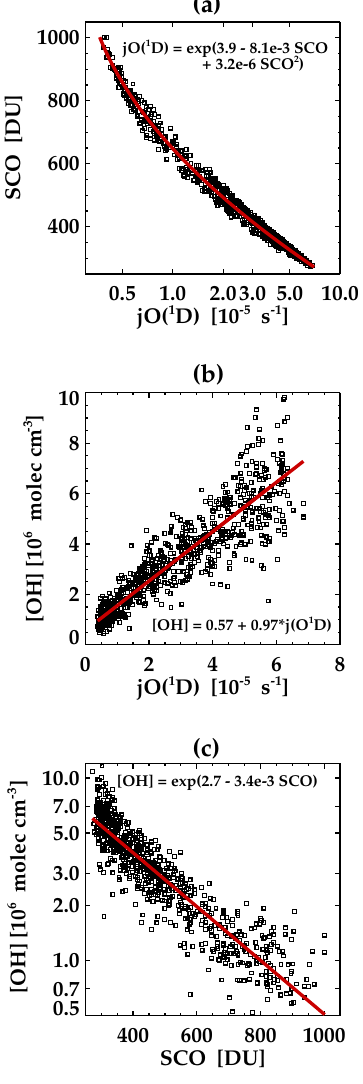
Figure 4. (a) Scatter plot of j with the slant column of O 3 O 1 D (SCO) at 6km of altitude. (b) Same, but for j and OH. (c) Same, O 1 D but for the SCO and OH. The results shown in this figure are those obtained from the combined simulation (kinetics and photolysis effects). Red lines denote least-squares fits between the variable pairs. The best fits are stated in the panels, with [OH] in units of 10 6 molcm − 3 , j in units of 10 − 5 s − 1 , and the SCO in Dobson O 1 D